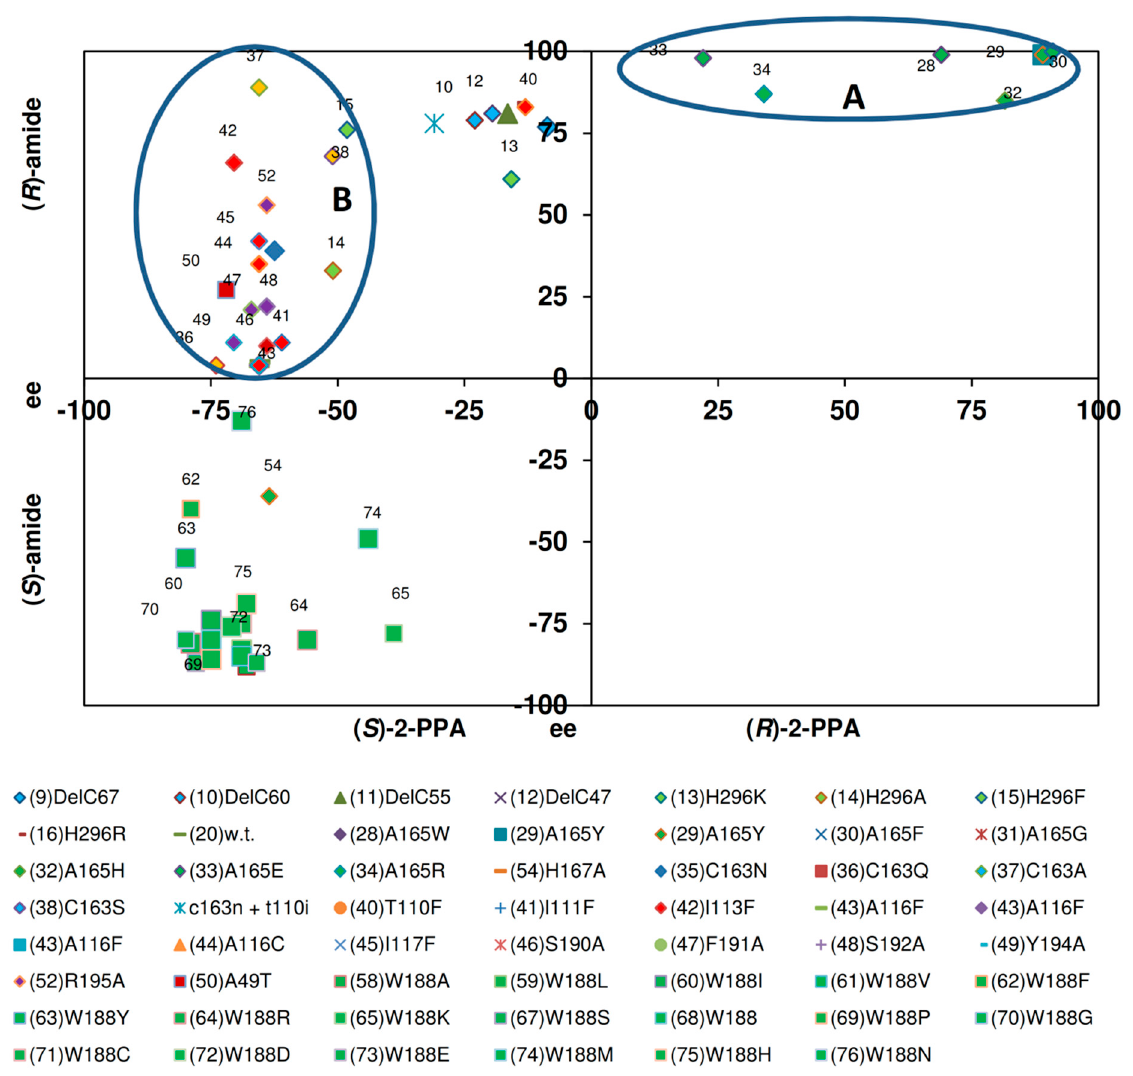
Figure 11. Correlation of the ee-values of the amides and acids formed from ( R , S )-2-phenylpropionitrile by various nitrilase variant. The data were taken from previous publications (see Figure 6), but those variants were excluded from the analysis which formed less than 1% of 2-PPAA (in relation to the amounts of 2-PPA formed).